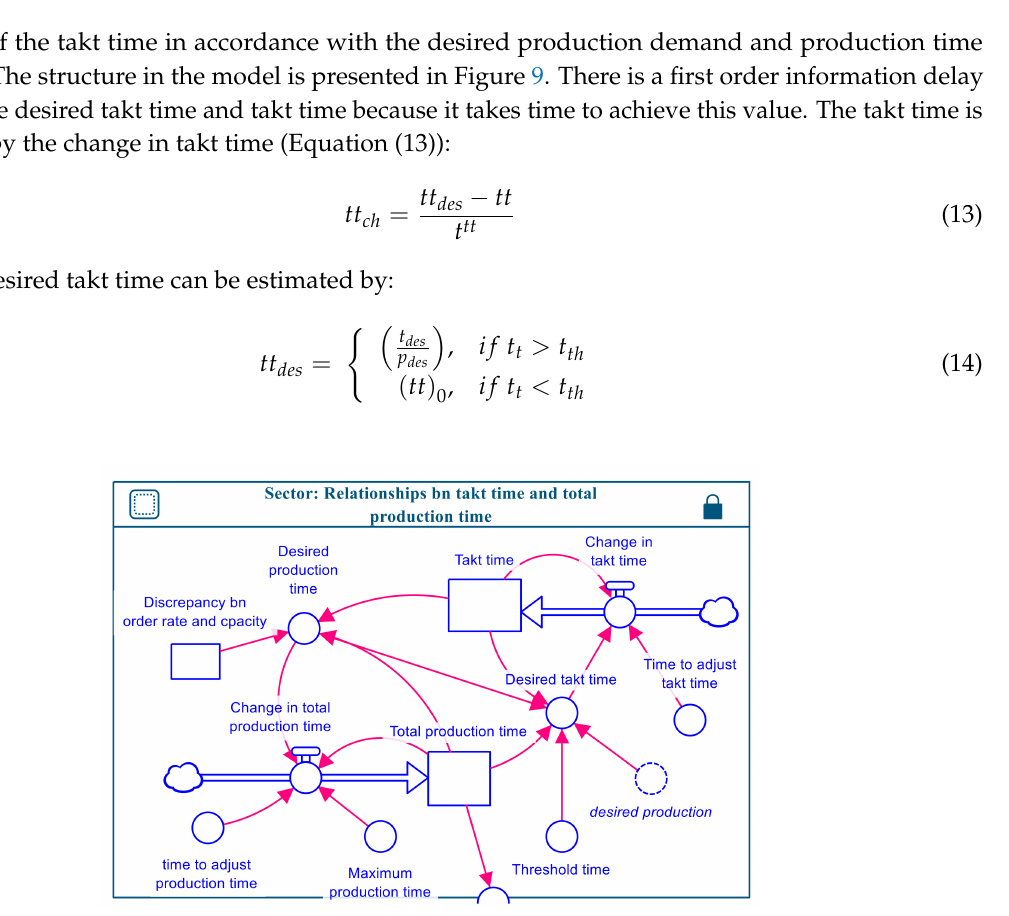
Figure 9. Structure of machining system module for flexible takt